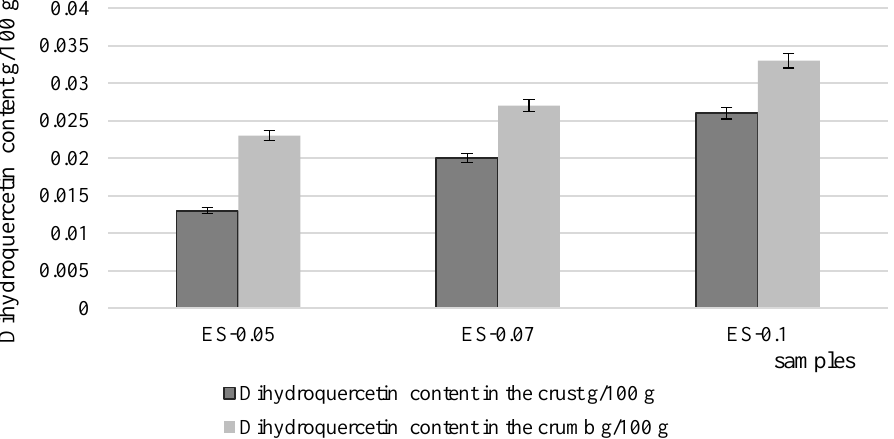
Figure 6. Dihydroquercetin content in bread samples (in the crumb and crust–crust layer), %. Taken together, loss of dihydroquercetin in the crust and subcrust layers is, on